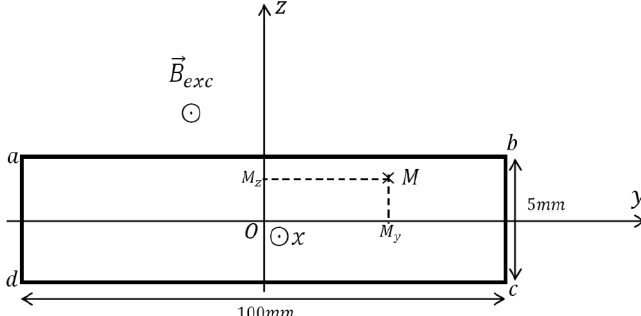
Figure 10 : Theoretical (a) and experimental (b) values of 𝐵 in the case of the flawless plate (A), and of the defective (B) one for 𝑥 = 45 𝑚𝑚